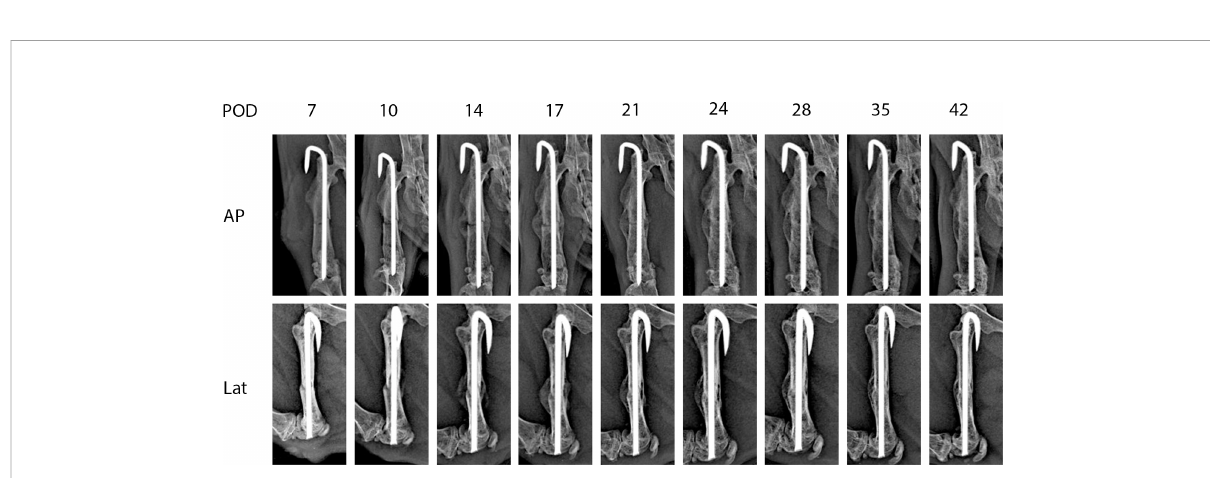
FIGURE 2 Representative X-rays from each time point used for mRUST scoring. AP, anteroposterior; Lat, lateral; POD, post-operative